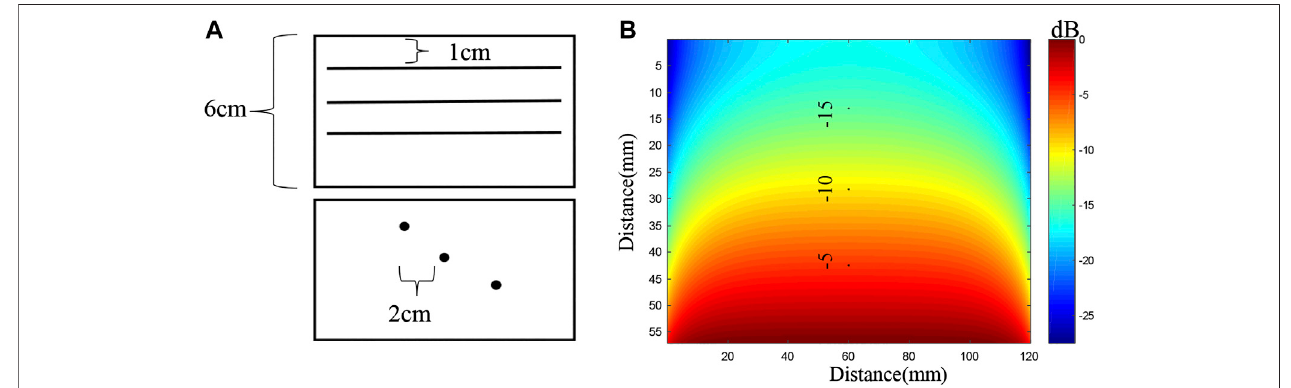
FIGURE 7 | (A) Structure of phantom; (B) ϕ map of the central cut plane.